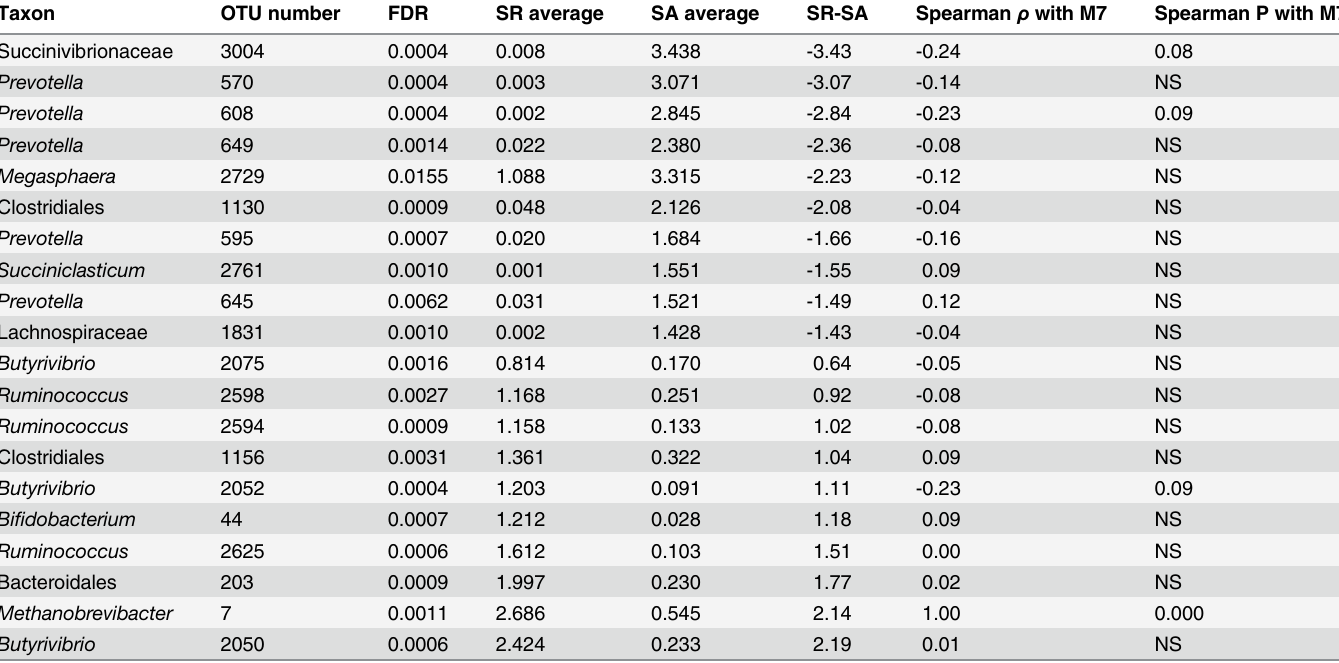
Table 4. Spearman correlation analysis between OTU M7and OTUs showing the largest (top 20) changes in relative abundance between rumen solid of group R and group A. Taxon OTU number FDR